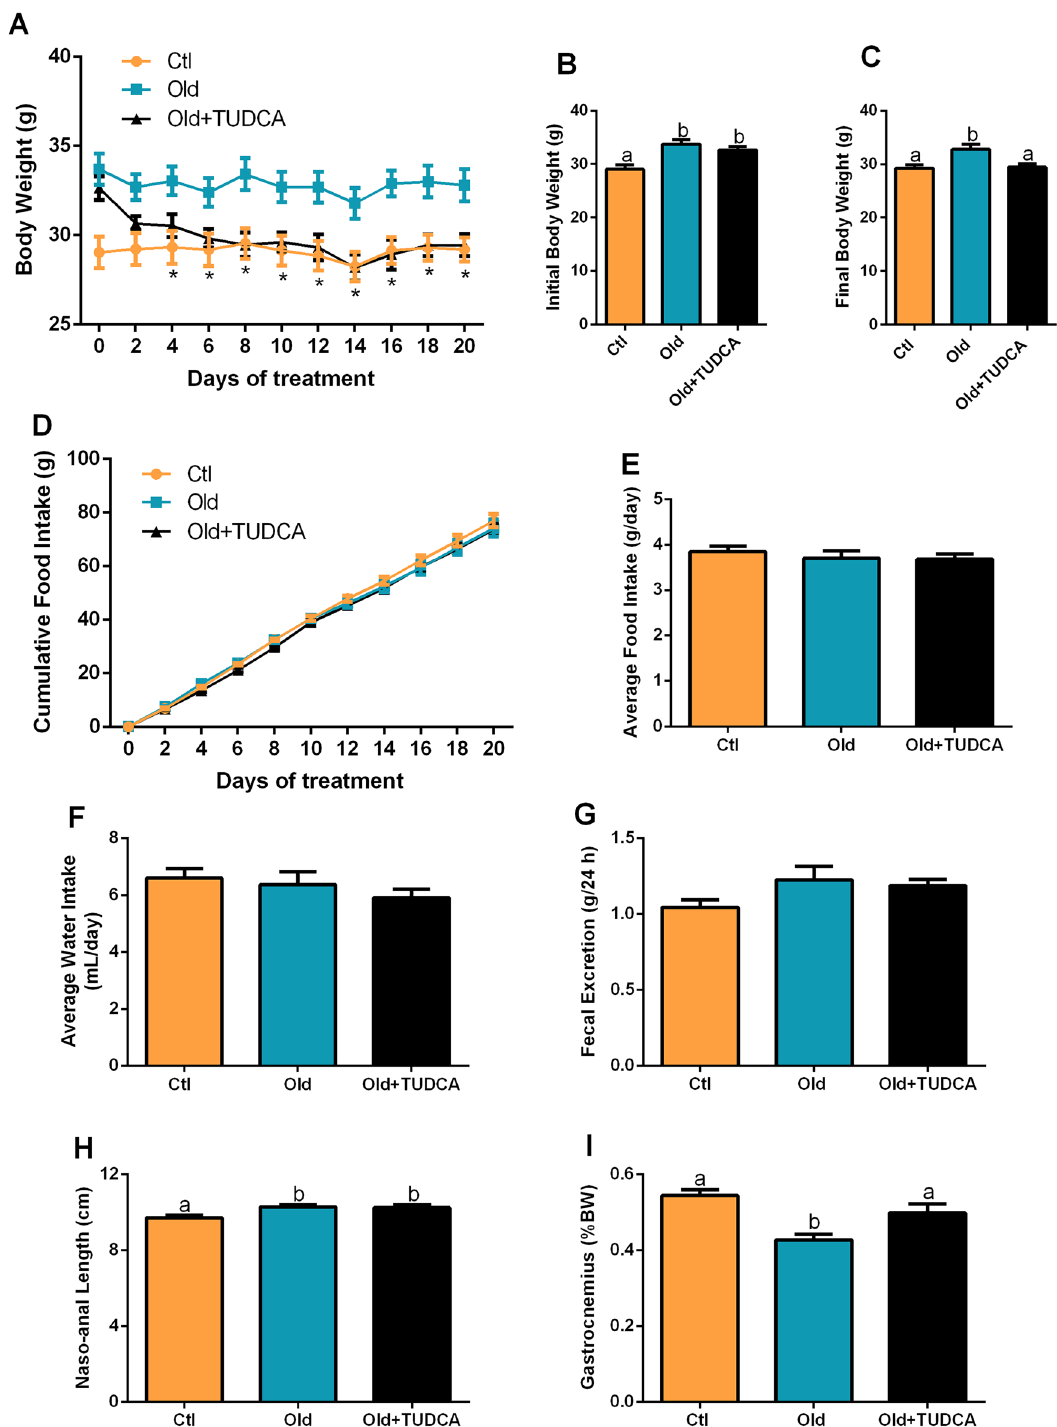
Figure 1. Effects of TUDCA treatment upon body and food parameters. Body weight over the treatment ( A ), initial ( B ), and final ( C ) body weight. Cumulative food intake over 20 days ( D ), and average daily food ( E ) and water ( F ) intake. Fecal excretion during 24 h ( G ). Naso-anal length ( H ), and gastrocnemius weight ( I ). Data are expressed as means ± SEM (n = 6–10). Statistical analysis was performed using the one-way ANOVA test, followed by Tukey post-hoc-test. Letters shared in common between groups indicate no significant difference. Different letters (a and b) indicate statistical difference between groups and * indicate Old is different from Ctl and OLD + TUDCA mice (P ≤